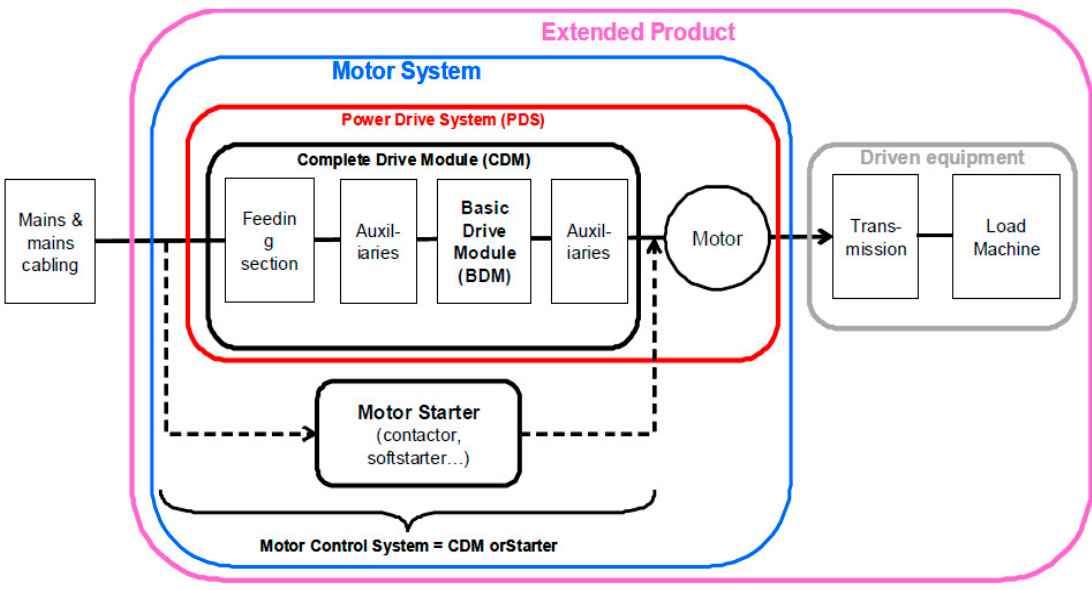
Figure 2. Boundaries of the complete drive module, power drive system, motor system, driven equipment, and extended product, as set out in the IEC 61800-9-2 ed.1.0 standard [12]. Copyright